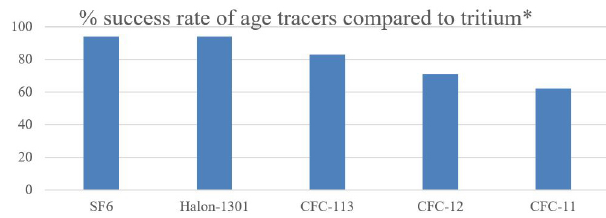
Figure 11. The success rate of Halon-1301, SF 6 and the CFCs CFC- 11 and CFC-12 compared to tritium in this study; ∗ assuming tritium has a success rate of